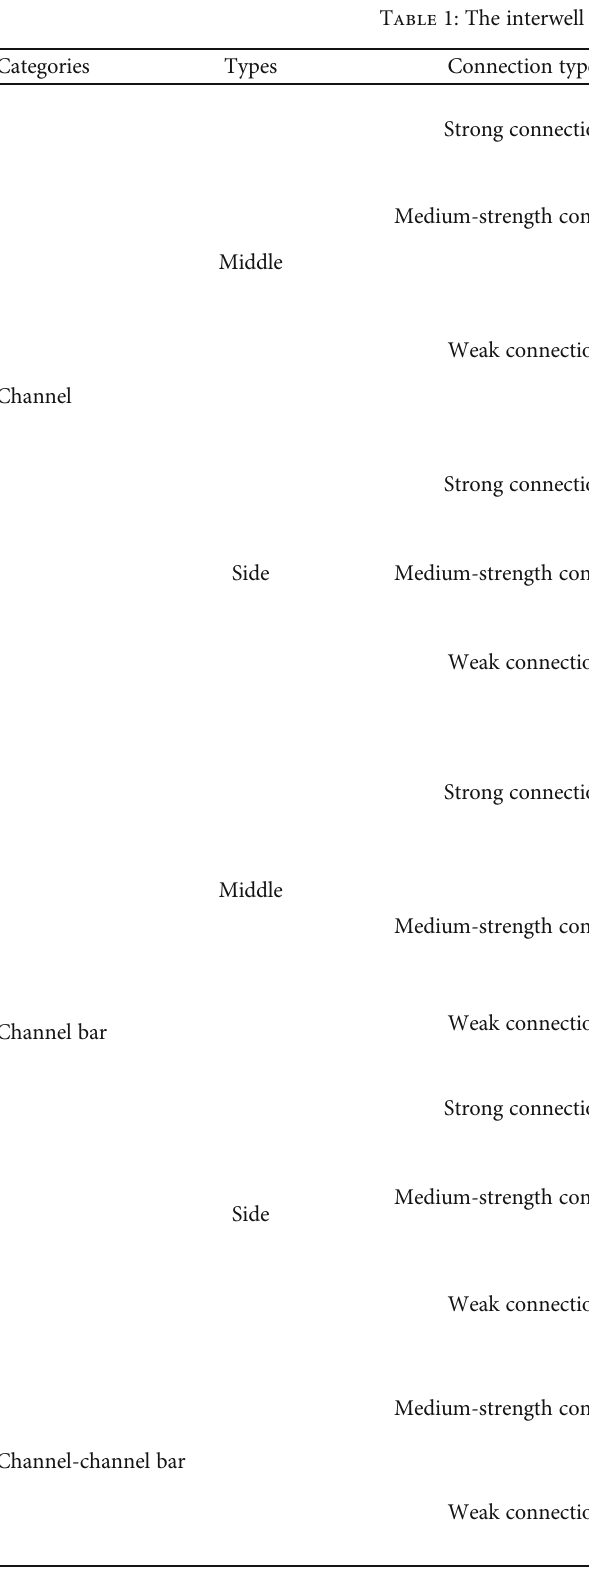
Table 1: The interwell connection structure